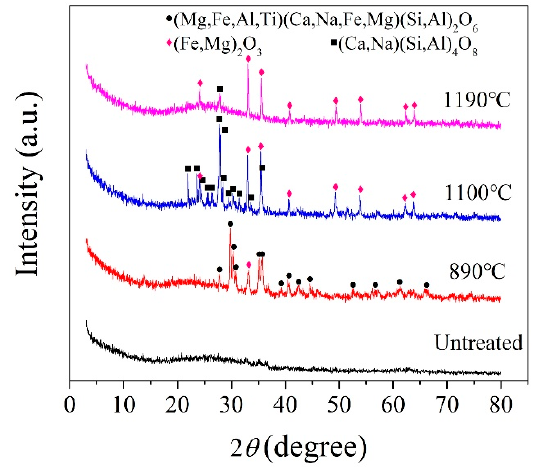
Figure 5. XRD patterns of the BG obtained at different crystallization temperatures.